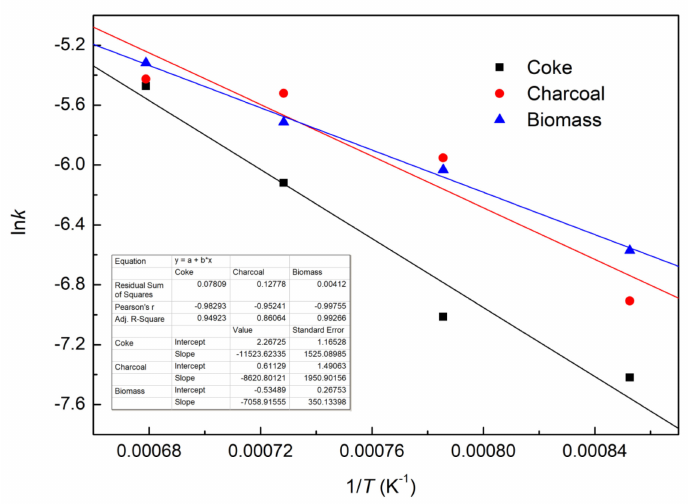
Figure 9. Plots of ln k vs. 1/ T